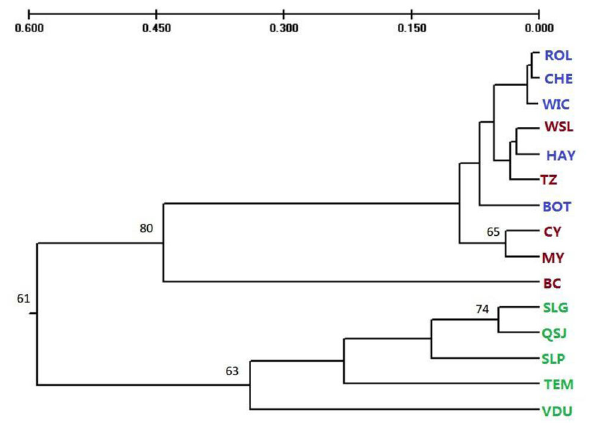
Figure 3. Unweighted pair group method with arithmetic mean (UPGMA) tree depicting the relationships between 15 Solanum rostratum populations from Mexico, the U.S.A. and China. The tree is based on the standardized genetic distances among populations (Nei's D ) calculated from a S matrix of genotypes at 10 microsatellite loci. The numbers above the nodes represent percentage of bootstrap support (1000 replications). Only bootstrap support above 50% is shown. Population codes as in Table 1.